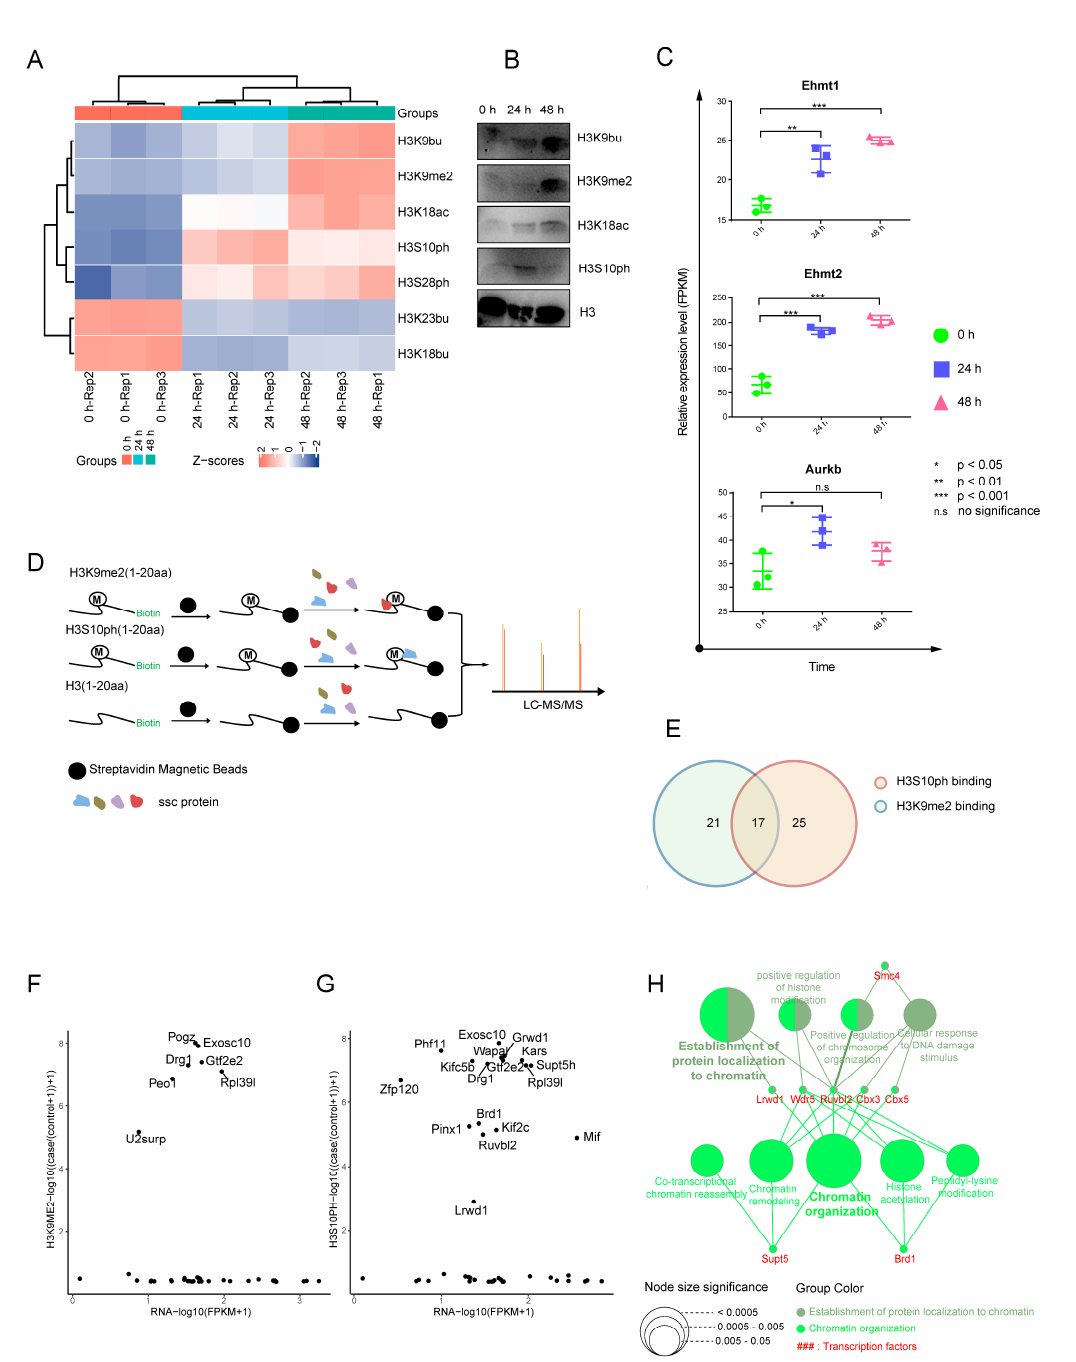
Figure 3. Histone modification profiling and enrichment of modification interacting proteins during SSC differentiation. ( A ) Heatmap of differentially expressed histone modifications at different stages of SSC differentiation. ( B ) Differentially expressed modifications identified by western blot validation. ( C ) Relative expression levels of histone modification enzymes EHMT1, EHMT2, and AURKB according to RNA–seq. The y –axis is the FPKM value. ( D ) Schematic diagram of the process of enriching binding proteins with synthetic two histone modification peptides. ( E ) Venn diagram of H3K9me2 and H3S10ph binding proteins. ( F , G ) Co–analysis of protein expression and RNA expression level. ( H ) Gene ontology of 8 transcription factors pulled down by H3K9me2 and H3S10ph